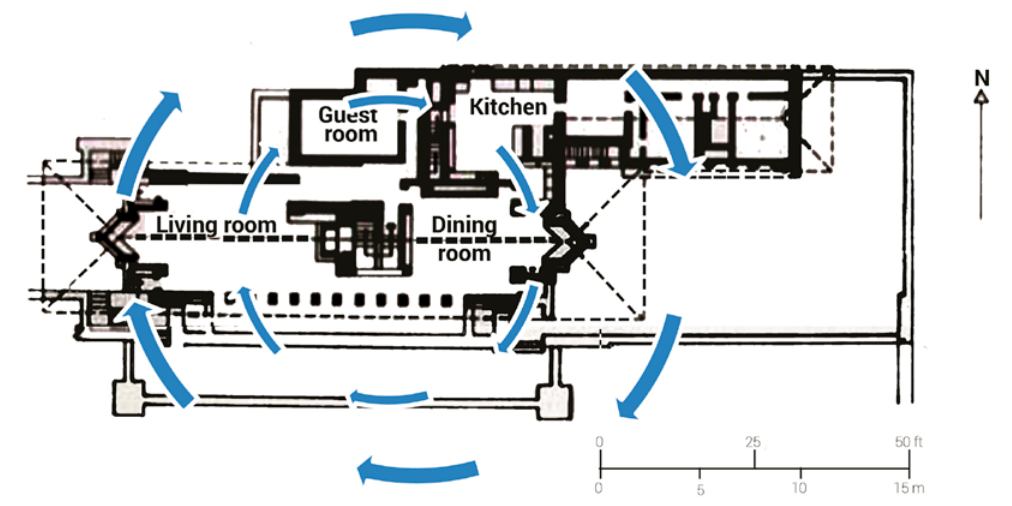
fig. 7. The central pinwheel configuration of spaces – robie House, Chicago 1909 (Etlin 1994). arrows inserted by the